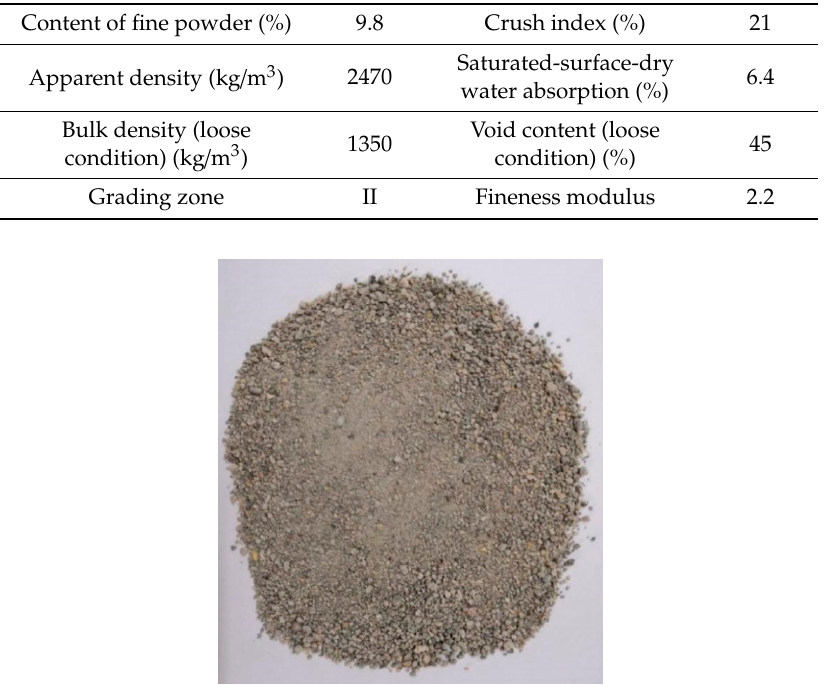
Figure 4. The particle grading curve of the produced CRFA. Table 3. The physical properties of the produced CRFA. Content of fine powder (%)